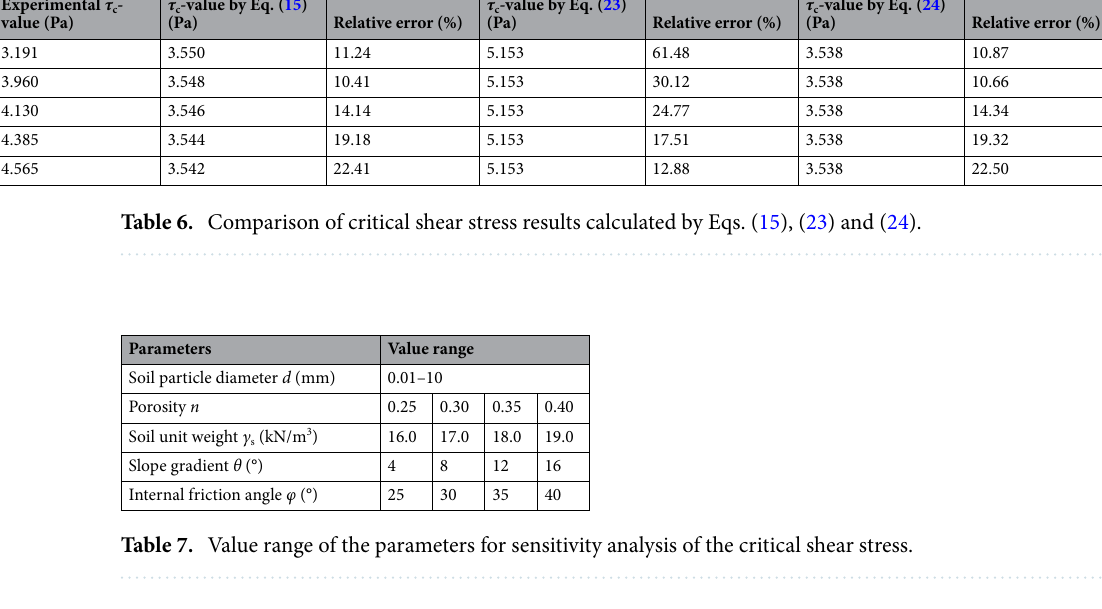
Table 7. Due to the influence of d and γ s on the bonding force, the parameter α was first analyzed with the increase of d . The slope gradient θ = 10° and the values of other parameters can be found in Table 1. The results of α varying with d and γ s can be seen in Fig. 9. Generally, α is negatively correlated with d and positively correlated with γ s . After d reaches 1 mm, the α -values no longer vary. Clearly, the α -curves show little difference when γ s = 18.0 kN/ m 3 and γ s = 19.0 kN/m 3 . When d equals 0.01 mm, the α -values are 0.2349 × 10 −7 m 3 /s 2 , 0.7260 × 10 −7 m 3 /s 2 ,